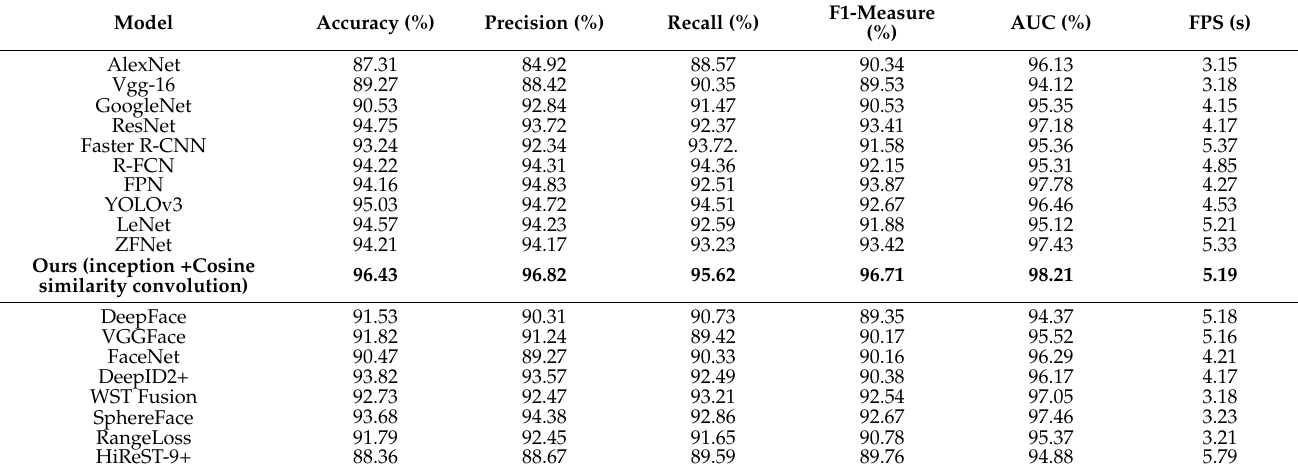
Table 3. Results of buckwheat disease